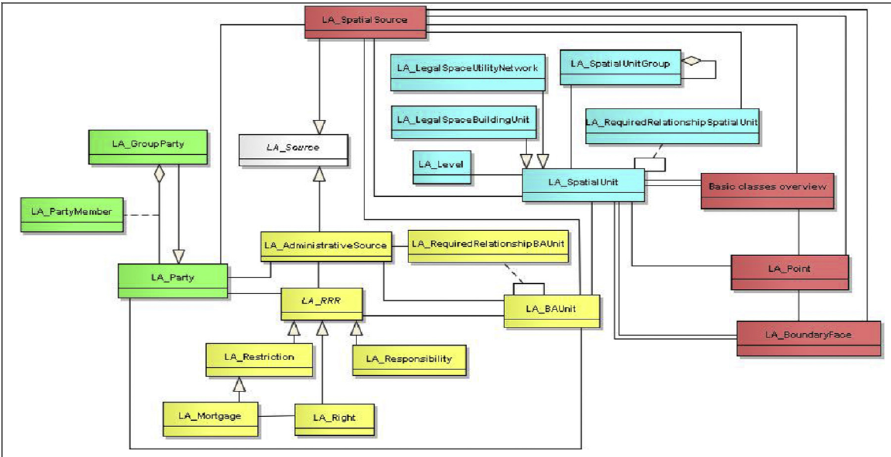
Figure 1 . The Land Administration Domain Model (Lemmen & Rohan,